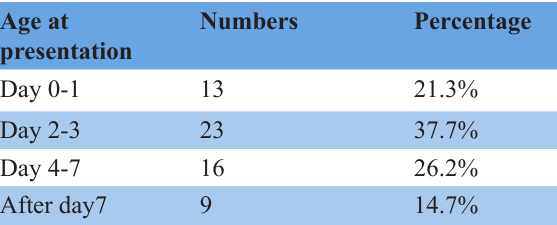
Table 2. Age at presentation to emergency